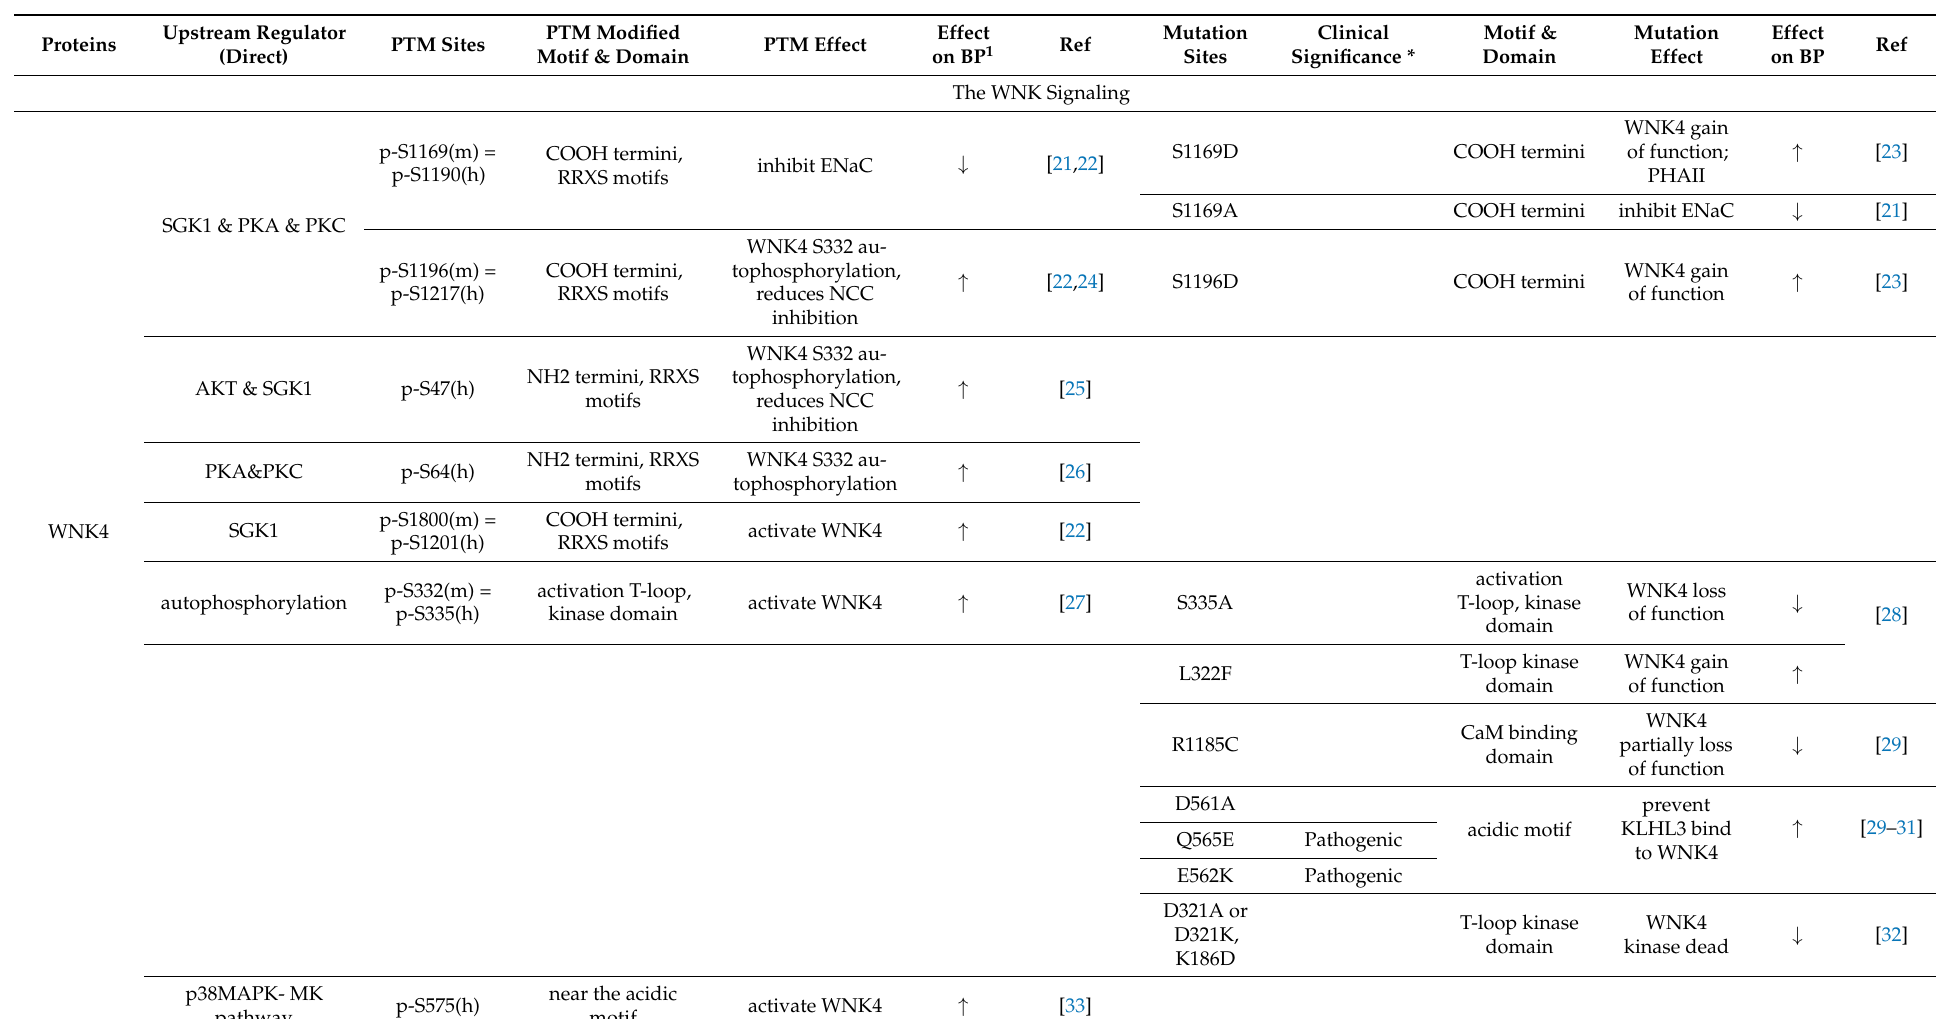
Table 1. PTMs and mutation sites of kinase cascade regulating renal ion channel. Abbreviations: BP, Blood pressure; m, mice; h, human; auto, autophosphorylation; pRTA, proximal renal tubular